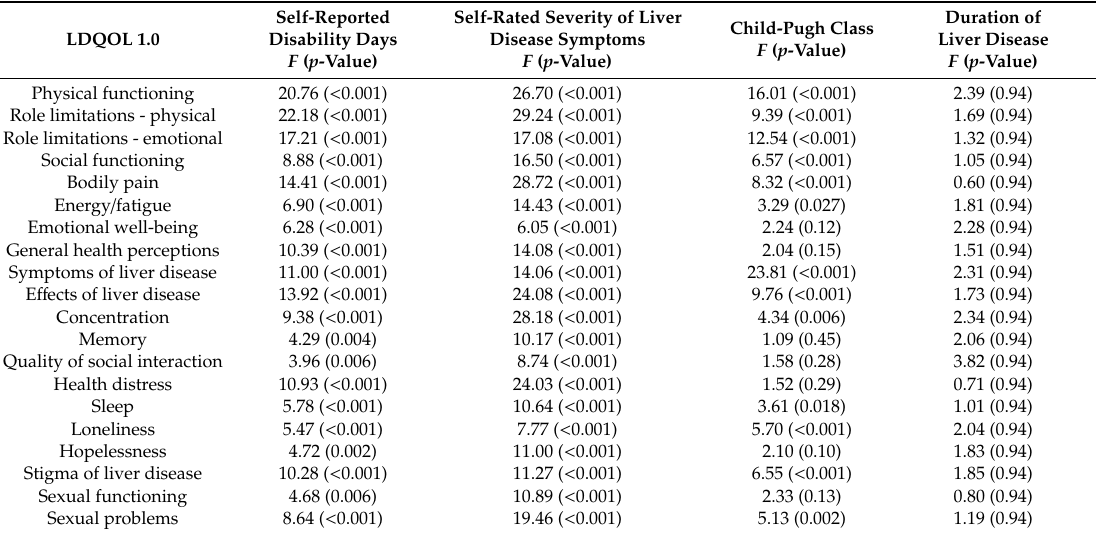
Table 4. Construct validity of the Korean LDQOL